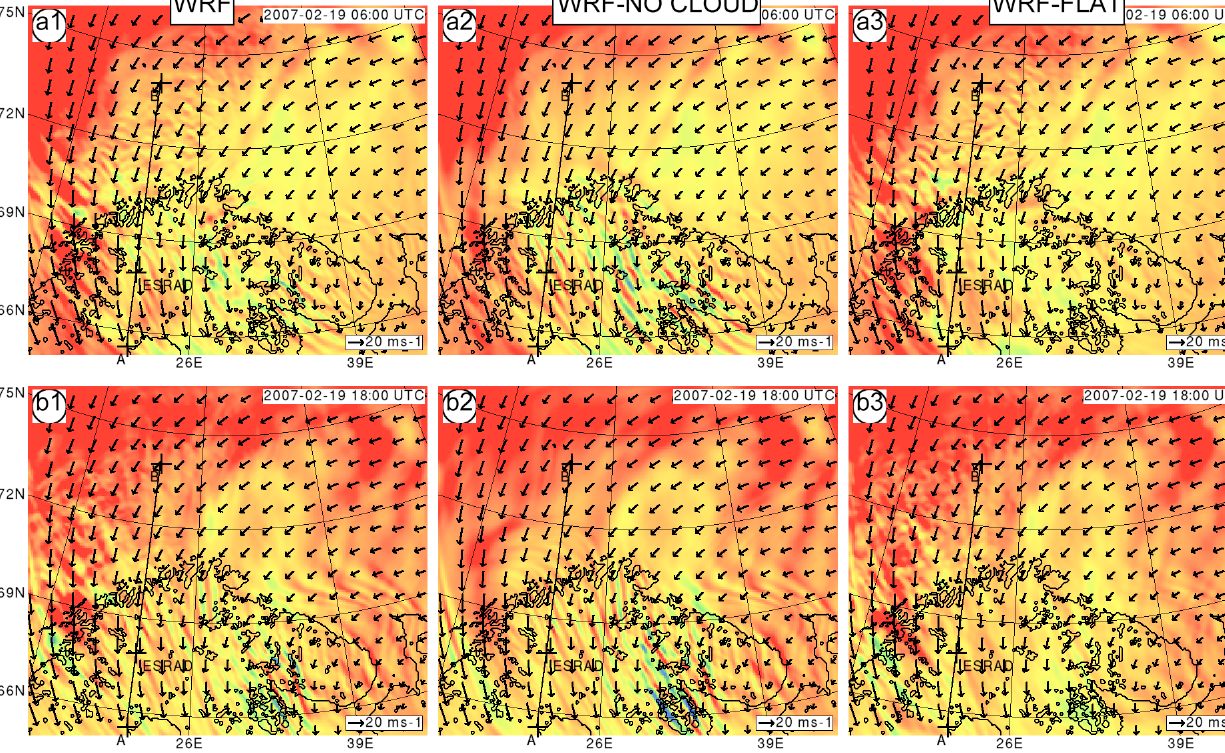
Figure 5. (a-b) Latitude-longitude cross-sections at 12 km altitude of buoyancy frequency (colour) in s − 1 and horizontal winds (arrows) in ms − 1 at 06:00 and 18:00UTC, 19 February 2007, computed from the WRF experiments. The buoyancy frequency scale is given in Fig. 3, and the wind scale by the arrow at the bottom right corner of each panel. The straight black line (A–B) gives the location of the vertical cross sections in Fig. 6. The distance between wind arrows is 80km. ESRAD radar location is indicated by a black cross along this line. (a1) – (b1) Simulation with clouds and orography; (a2) – (b2) simulation without clouds but with orography; (a3) – (b3) simulation with clouds but without orography;